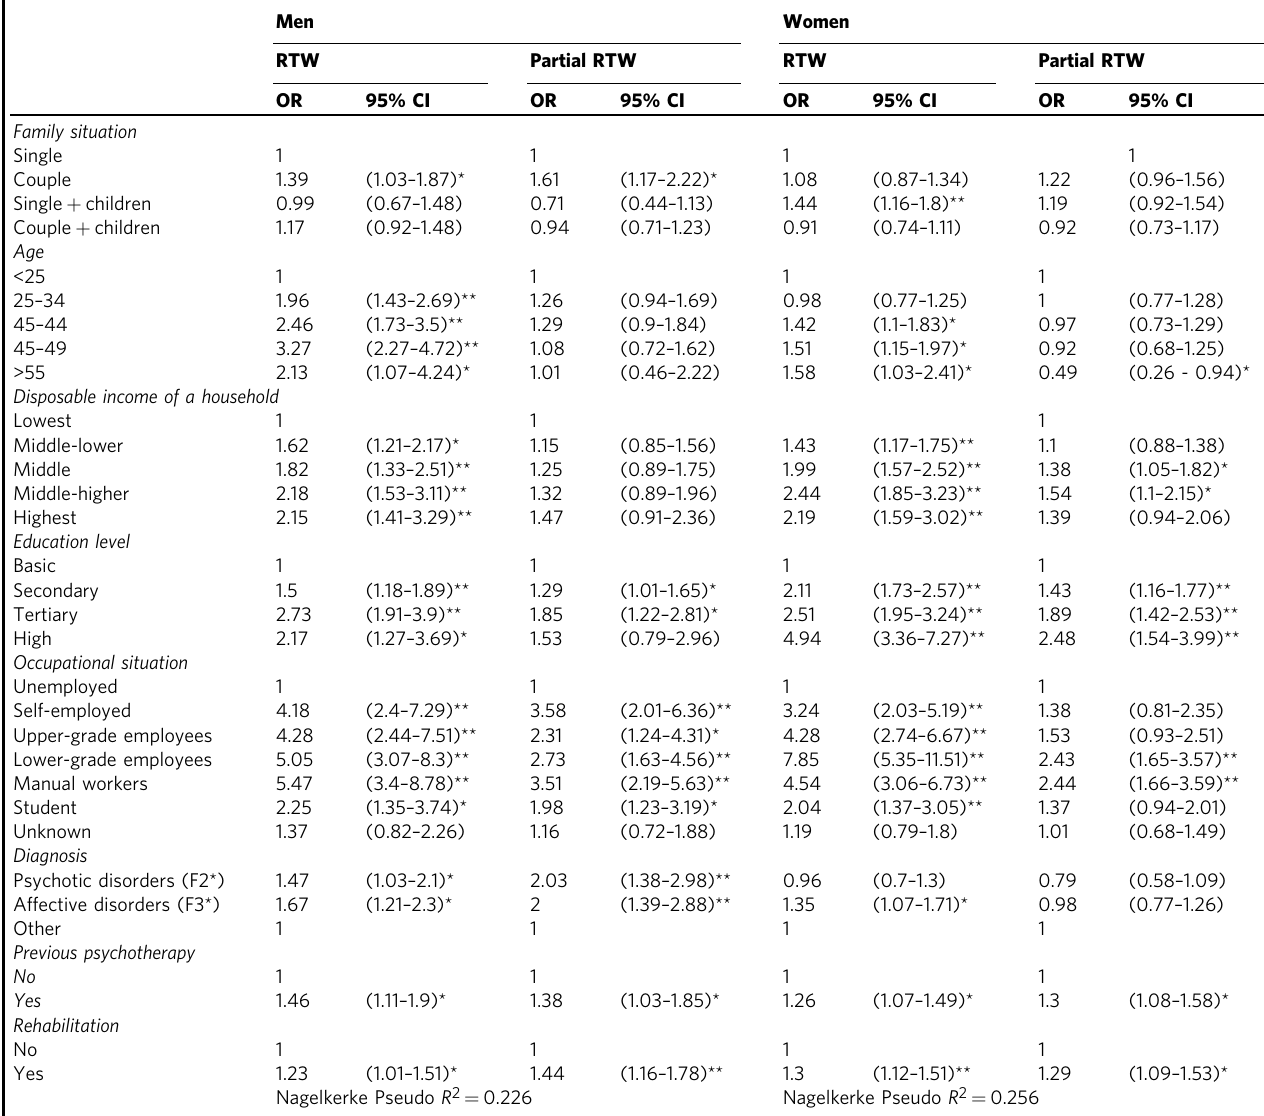
Table 2 A fully adjusted multinomial logistic model predicting total and partial return to work among a population of subjects temporarily retired due to psychiatric